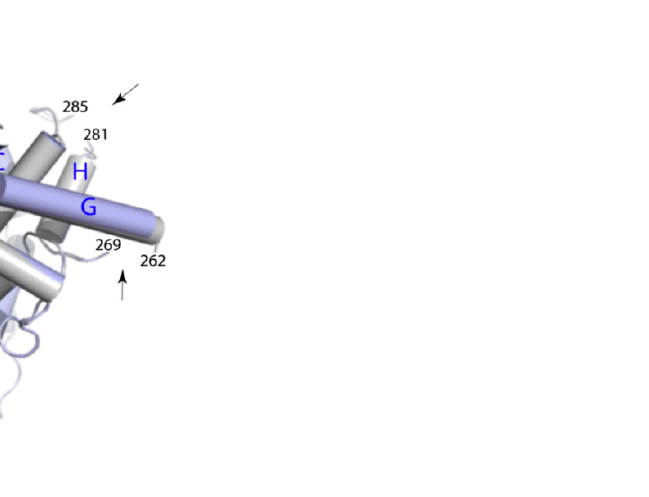
Figure 2. Superposition of two crystallographically independent molecules of CYP3A7. Molecules A and B and shown in gray and lavender, respectively. Helices and the N- and C-termini are labeled. The polypeptide breakage sites are indicated by arrows.